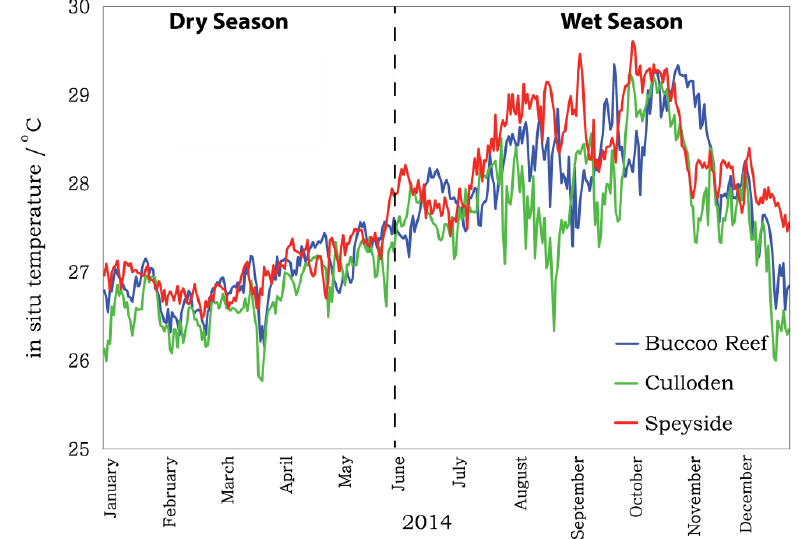
Figure 2. Time series of in situ temperatures for three coral reef monitoring stations in Tobago for 2014. Blue: Buccoo Reef, Green: Culloden and Red: Speyside.